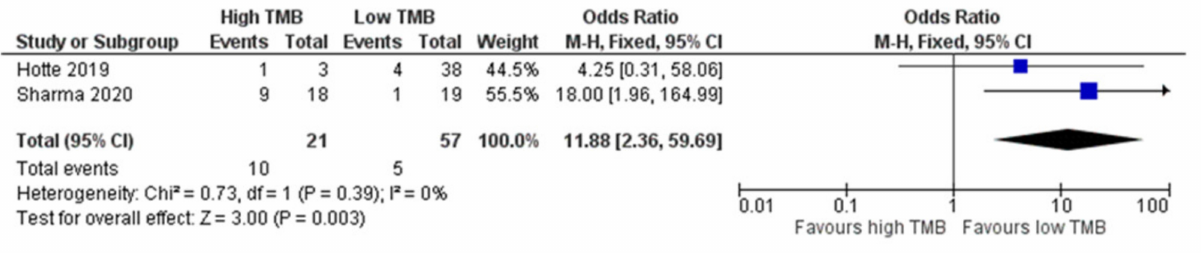
Figure 6. Forest plots for the impact of TMB on ORR. TMB, tumor mutation burden. Sharma et